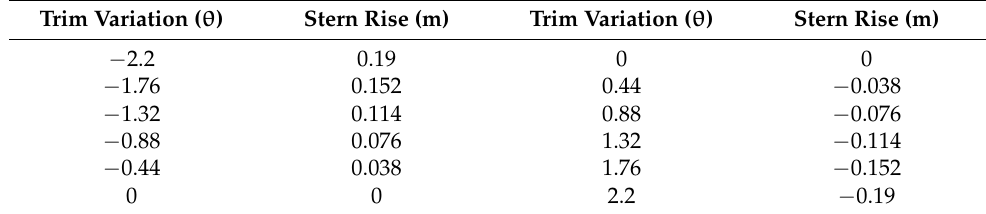
Table 4. Trim variation with different stern